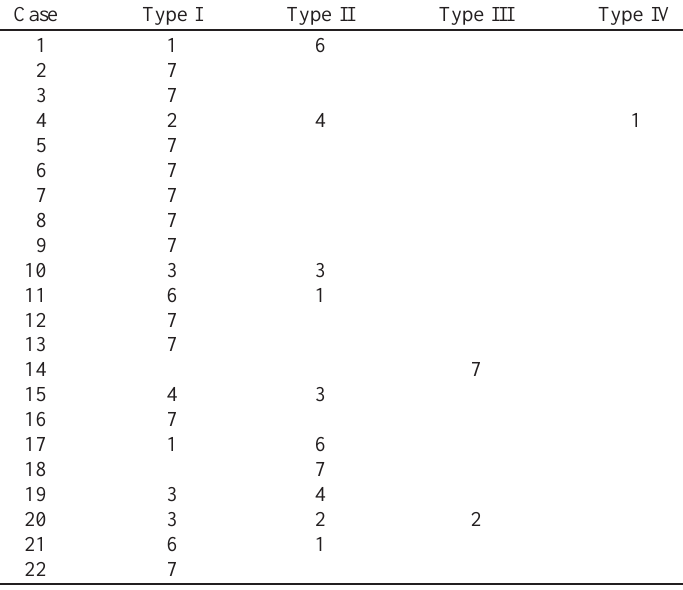
Table 2 Ploidy status of the different tumour locations